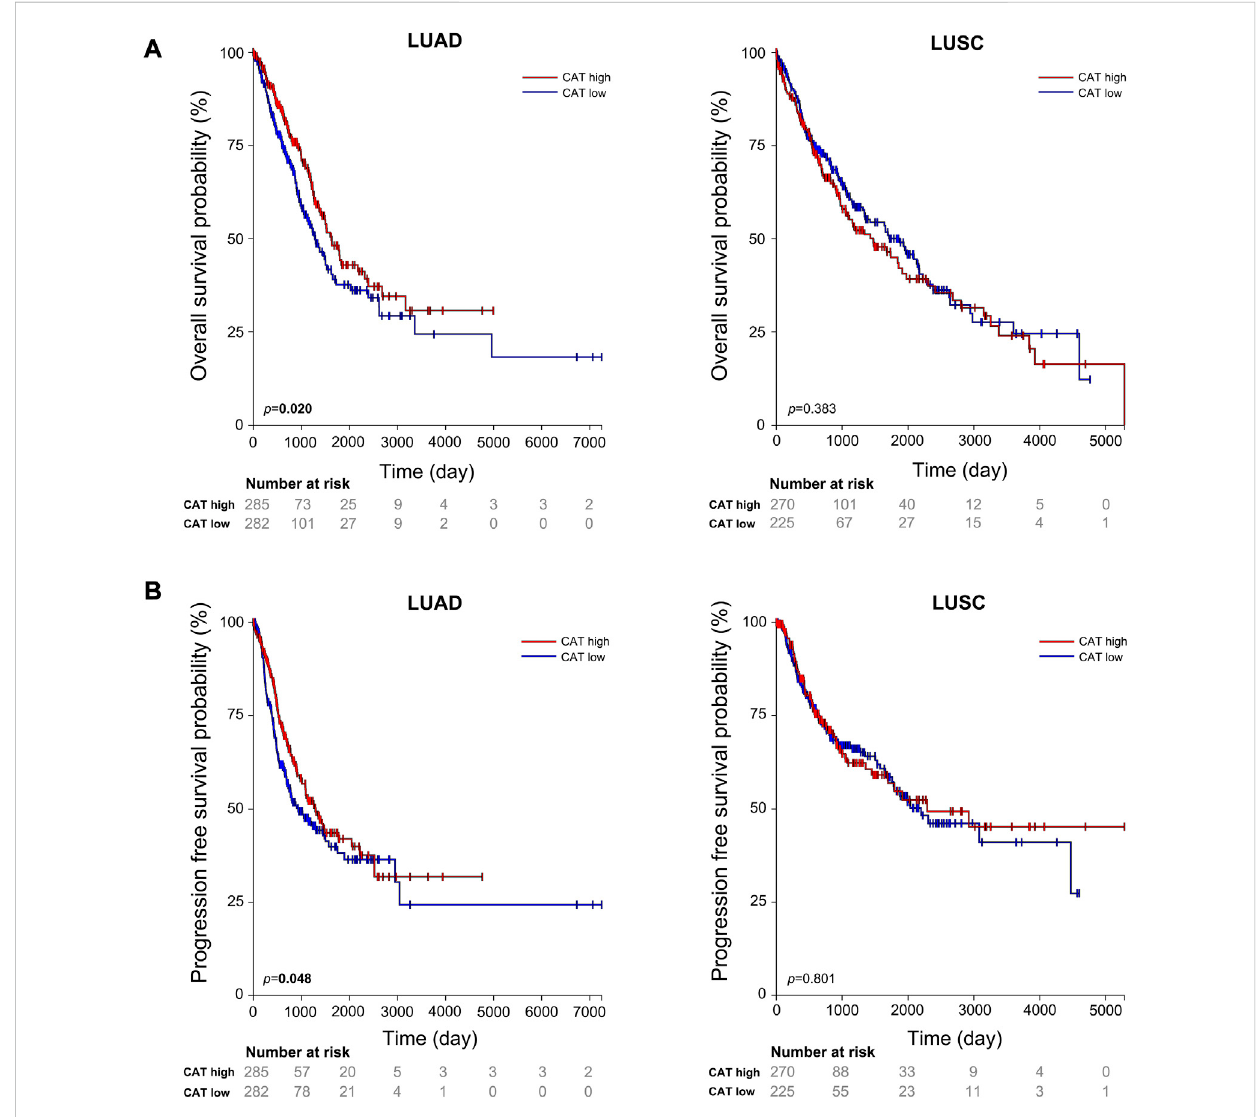
FIGURE 4 Association of the expression of CAT with lung cancer OS (A) and PFS (B) in TCGA LUAD and LUSC patients.